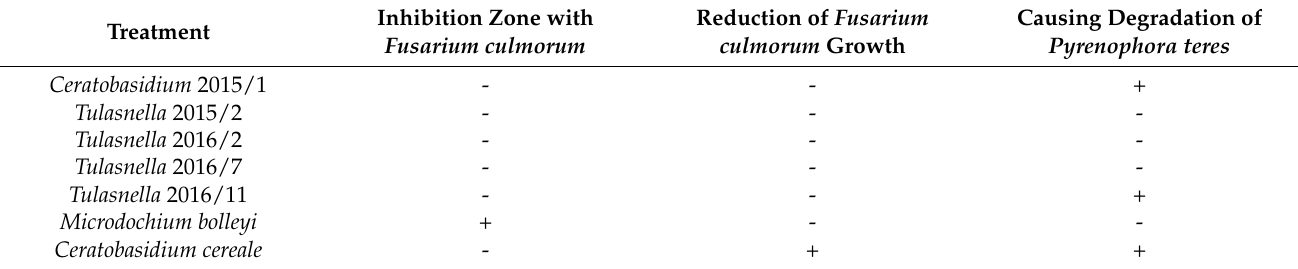
Table 1. Evaluation of in vitro tests of fungal isolates against plant pathogens Fusarium culmorum and Pyrenophora teres . +: presence, -: absence. The parameters of inhibition zone between fungal isolates and F. culmorum , reduction of Fusarium growth and ability to cause degradation of P. teres mycelium were evaluated.